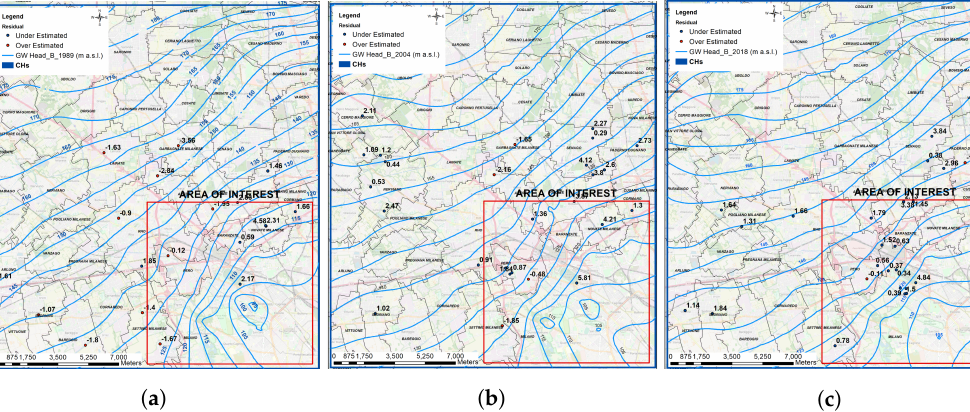
Figure A3. Computed heads for ( a ) SP0 (1989), ( b ) SP2 (2004), and ( c ) SP5 (2018).